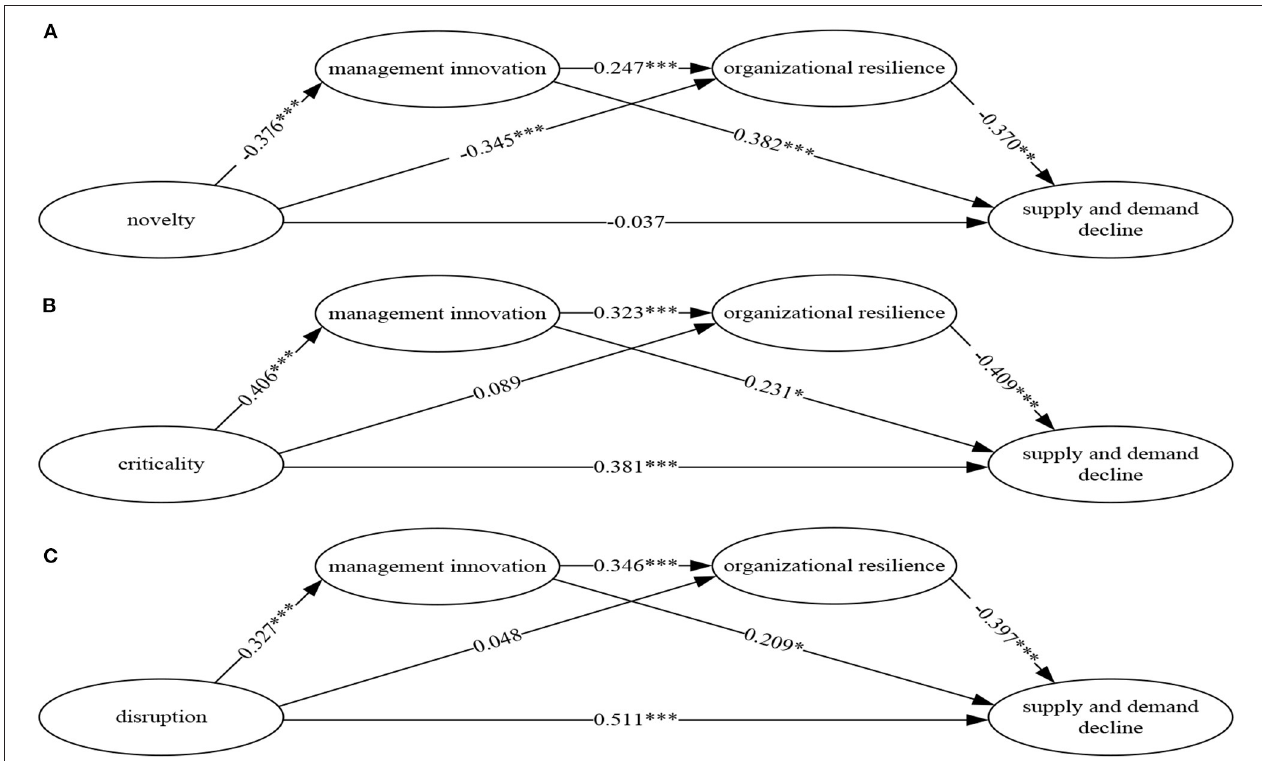
FIGURE 2 | (A–C) Path coefficient of COVID-19 pandemic event’s strength, MI , OR and supply and demand decline. *** P < 0.001, ** P < 0.010, * P <